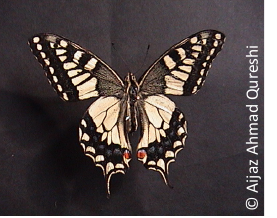
Image 9. Paplio machaon Image 10. Libythea lepita